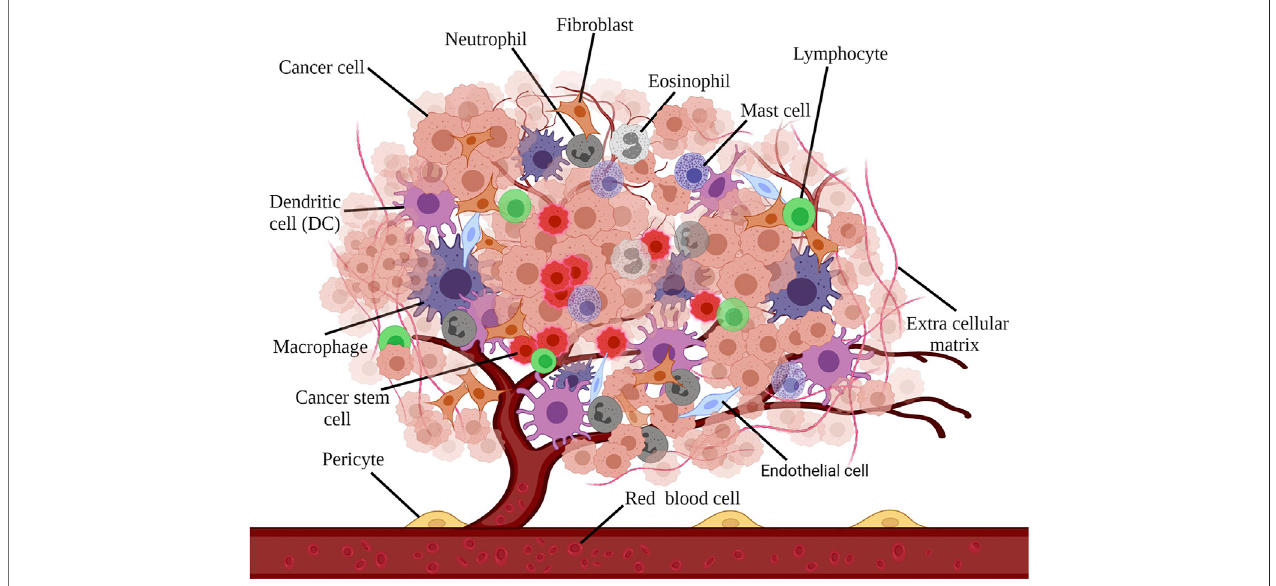
FIGURE 1 | Different cell types are present in TME: macrophages, fi broblasts, endothelial cells, neutrophils, eosinophils, mast cells, lymphocytes, dendritic cells, and dendritic cells, each representing a diverse impact on cancer tissue.